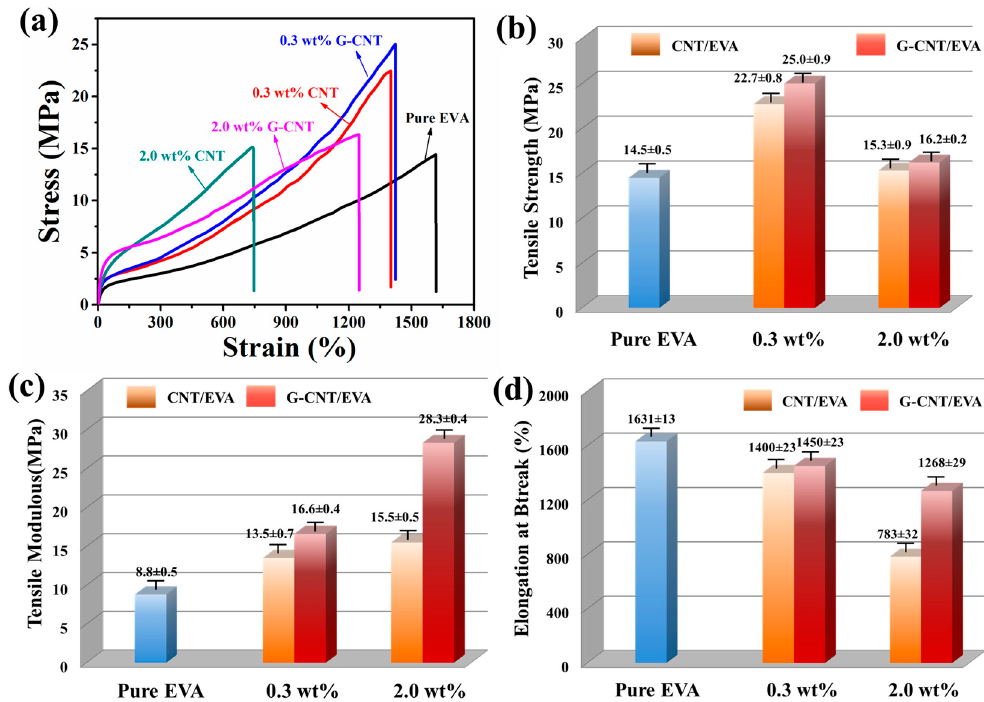
Figure 4. ( a ) Typical stress–strain curves of pure ethylene vinyl acetate (EVA) and its composites with various CNT loadings; ( b ) Tensile strength, ( c ) Young’s modulus, and ( d ) elongation at break of pure EVA and its composites.